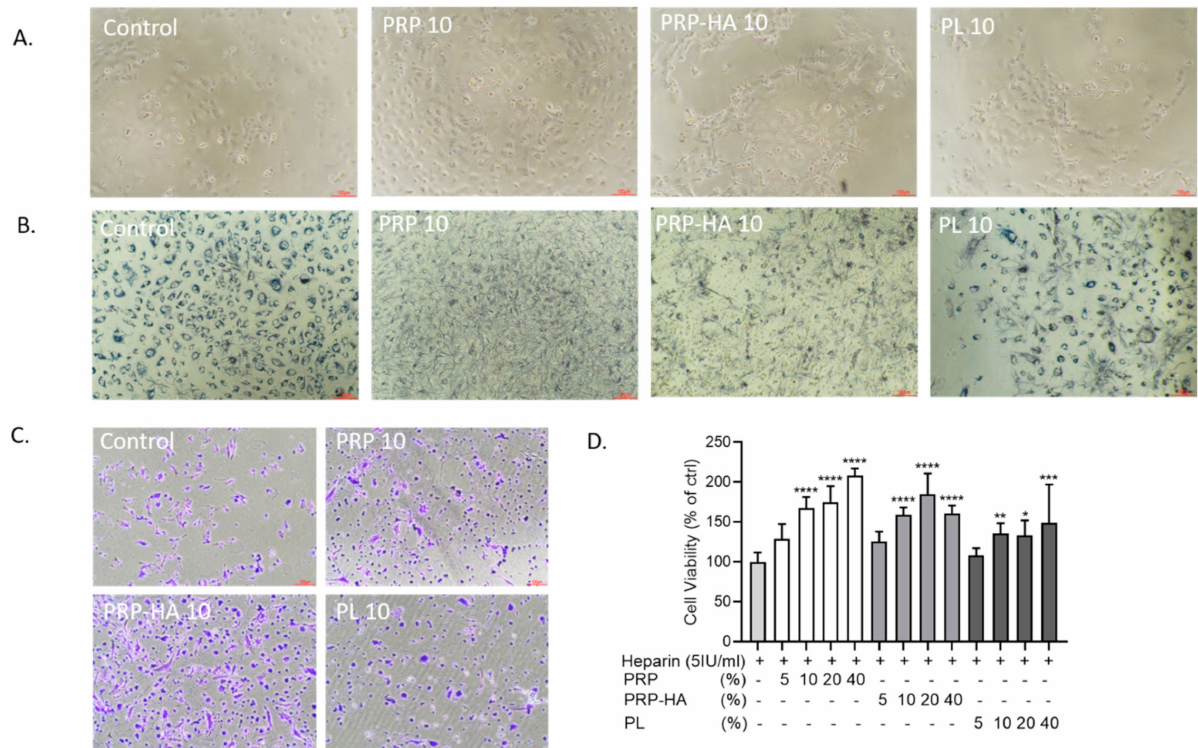
Figure 1. Effect of platelet-derived products on HUVEC cell behavior. ( A ). Bright-field optical photography of HUVEC in the presence of heparin, 10% PRP, 10% PRP-HA or PL after 3 days of culture ( B ). Cellular localization of the MTT formazan in HUVEC incubated for 72 h in different platelet-derived products. HUVEC in control medium and in PL have intracytoplasmic dark granules, while PRP and PRP-HA treated HUVEC show extruded formazan crystals. ( C ). HUVEC viability assessed by crystal violet staining in control and in PRP-, PRP-HA- and PL-treated cultures. ( D ). Quantification of the amount of the released dye by absorbance measurement (590 nm). N = 8, * p < 0.05, ** p < 0.01, *** p < 0.005, **** p < 0.001, compared to heparin condition. PRP (platelet-rich plasma), PRP-HA (platelet rich plasma combined with hyaluronic acid), PL (platelet lysates) HUVEC (human umbilical vein endothelial cells). Scale bars: 100 µ